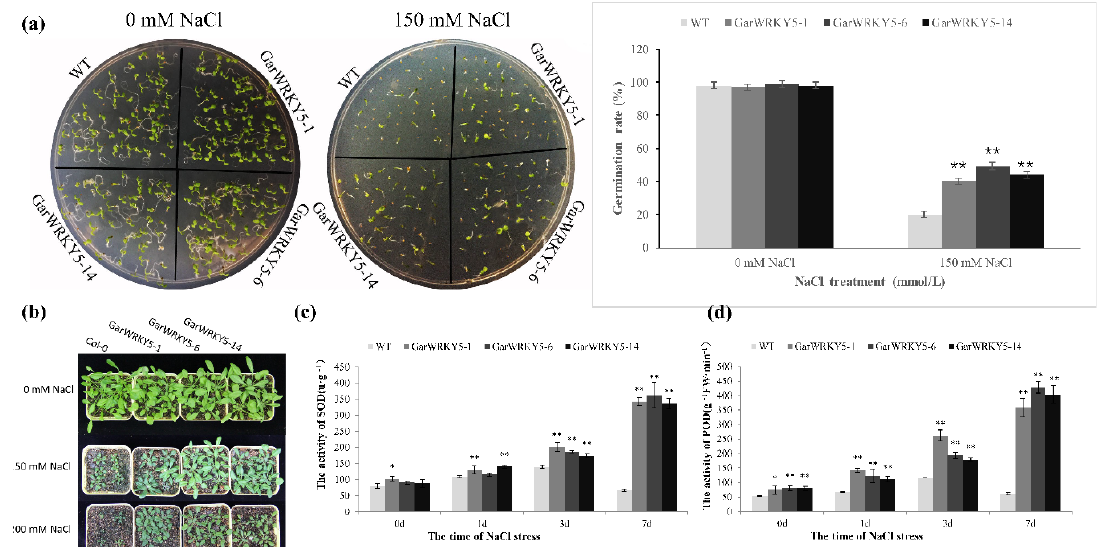
Figure 3. Overexpression of GarWRKY5 regulates salt tolerance in Arabidopsis. ( a ) The germination rate of transgenic Arabidopsis lines overexpressing GarWRKY5 gene. ( b ) GarWRKY5 -OE lines were grown on soil medium containing 0, 150, and 200 mM NaCl. ( c ) The activity of superoxide dismutase (SOD). ( d ) The activity of peroxidase (POD). The SOD and POD activities were assayed in the three independent GarWRKY5 -overexpressed transgenic lines ( GarWRKY5 -1, GarWRKY5 -6, and GarWRKY5 -14), with three independent biological replicates of each line. Student’s t -test: * p < 0.05 and ** p < 0.01. SD was used to calculate the error bars.